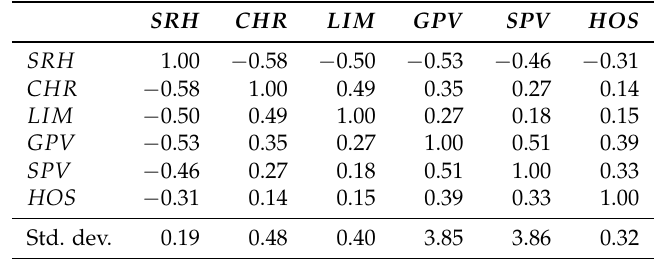
Table 3. Correlation coefficients and standard deviation of the indicator